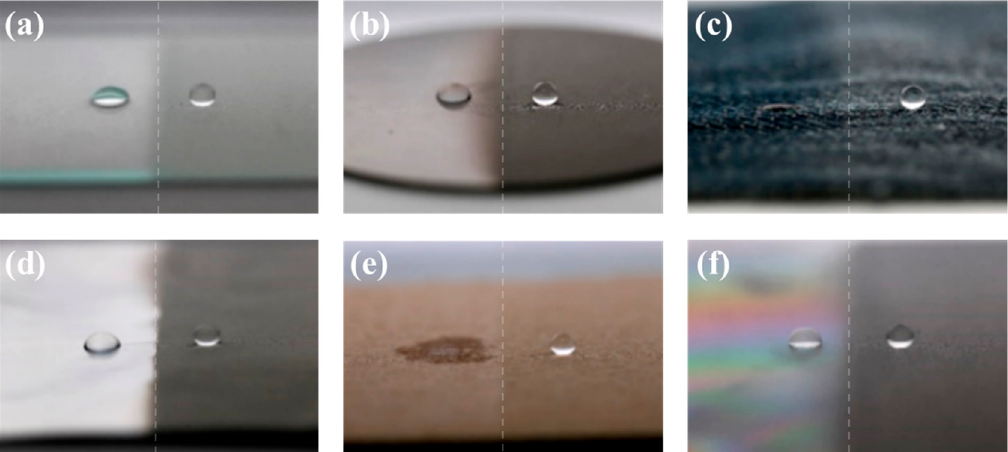
Figure 6. Photographs of water droplets on ( a ) glass, ( b ) metal, ( c ) fabric, ( d ) aluminum foil, ( e ) paper, ( e ) uncoated plastic surface, and ( f ) coated plastic surface.